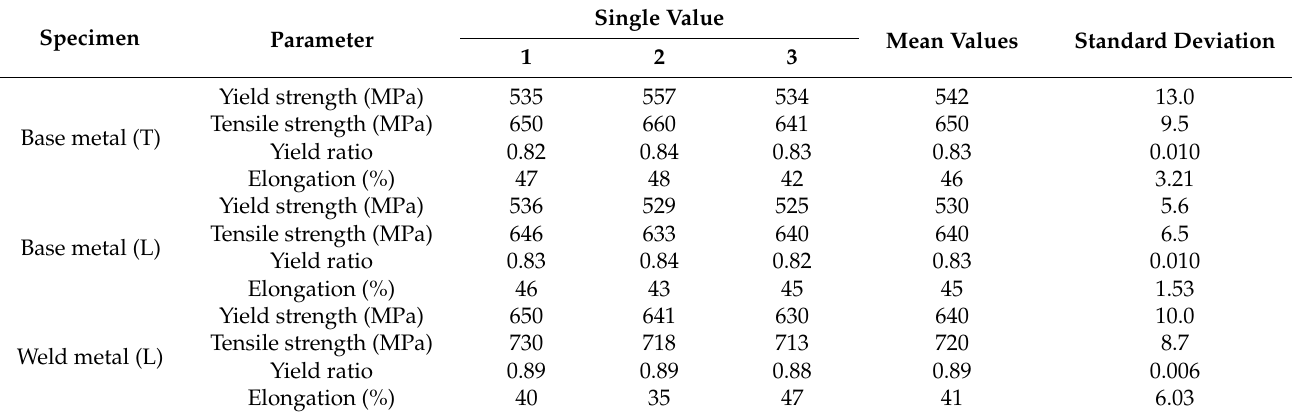
Table 1. Tensile properties of the